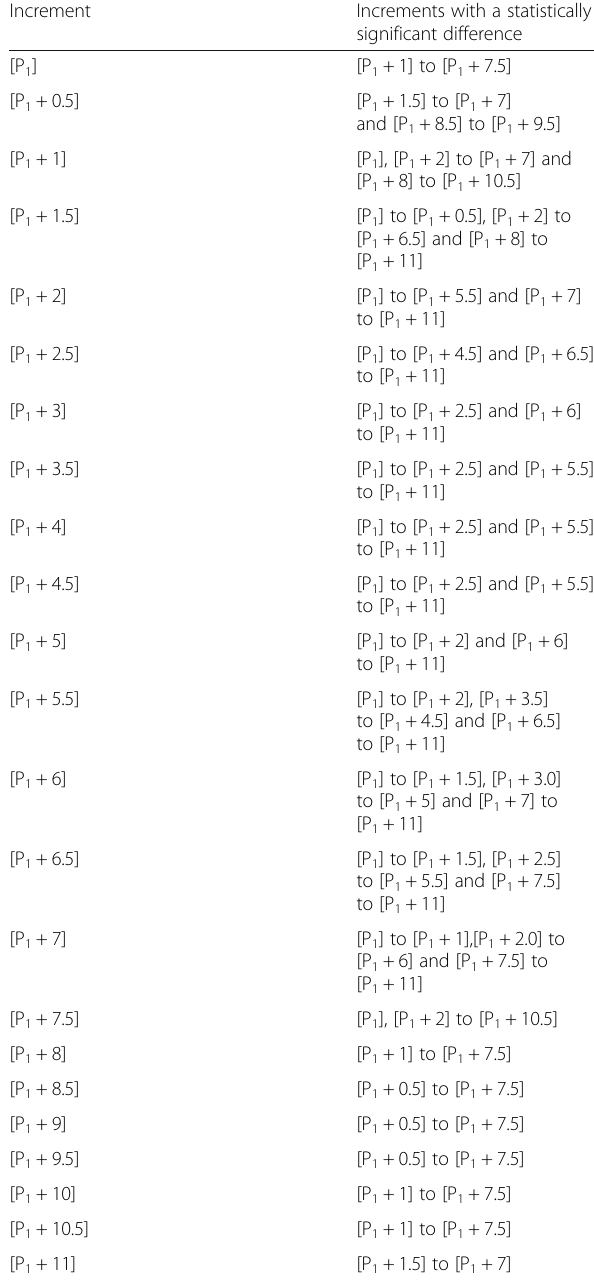
Table 4 Post-hoc Tukey test summarized and presented in the table below. The left side of the table shows an increment while the right side shows which increments were statistically significant different ( p < 0.05) from that increment